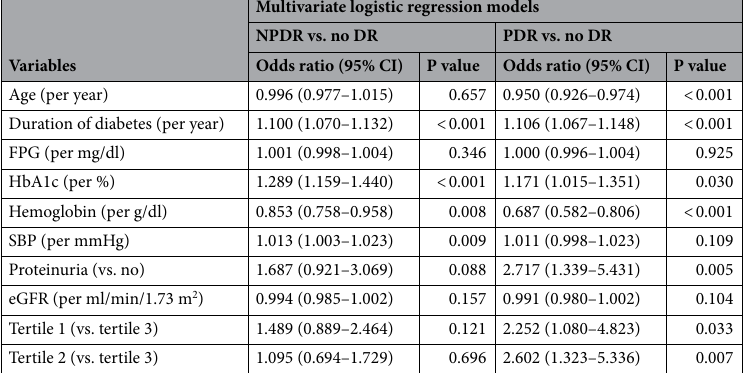
Table 3. The association of GNRI categories with diabetic retinopathy. SBP, systolic blood pressure; FPG, fasting plasma glucose; Hemoglobin A1c, HbA1c; eGFR, estimated glomerular filtration rate; GNRI, geriatric nutritional risk index.